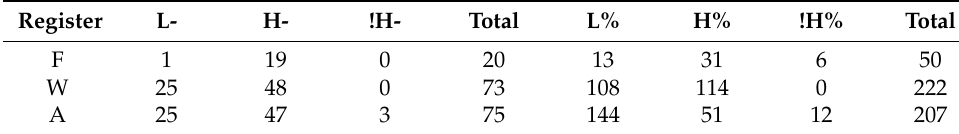
Table 3. Token count of all edge tone labels, by register code.